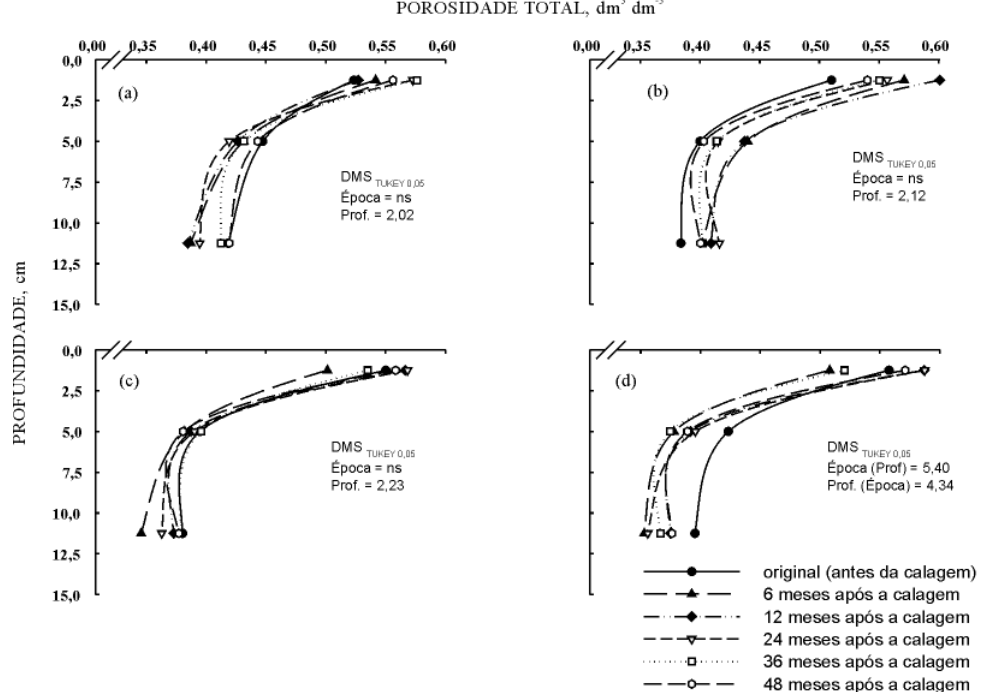
Figura 2. Porosidade total do solo em diferentes épocas de avaliação, profundidades e sistemas de manejo. (a) convencional durante 12 anos; (b) semeadura direta com revolvimento do solo a cada quatro anos; (c) semeadura direta durante oito anos; (d) semeadura direta durante